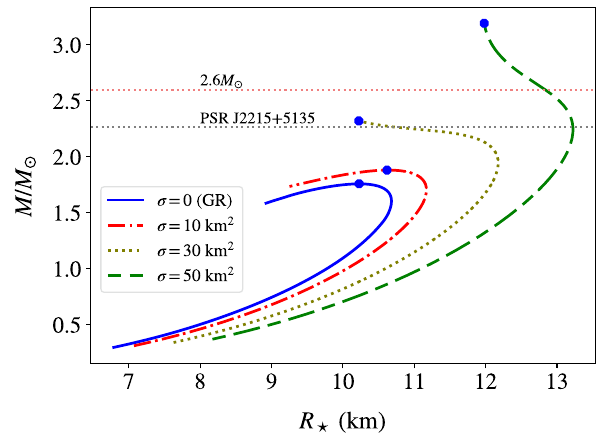
Fig. 1 Mass–radius relation of quark stars for different values of σ